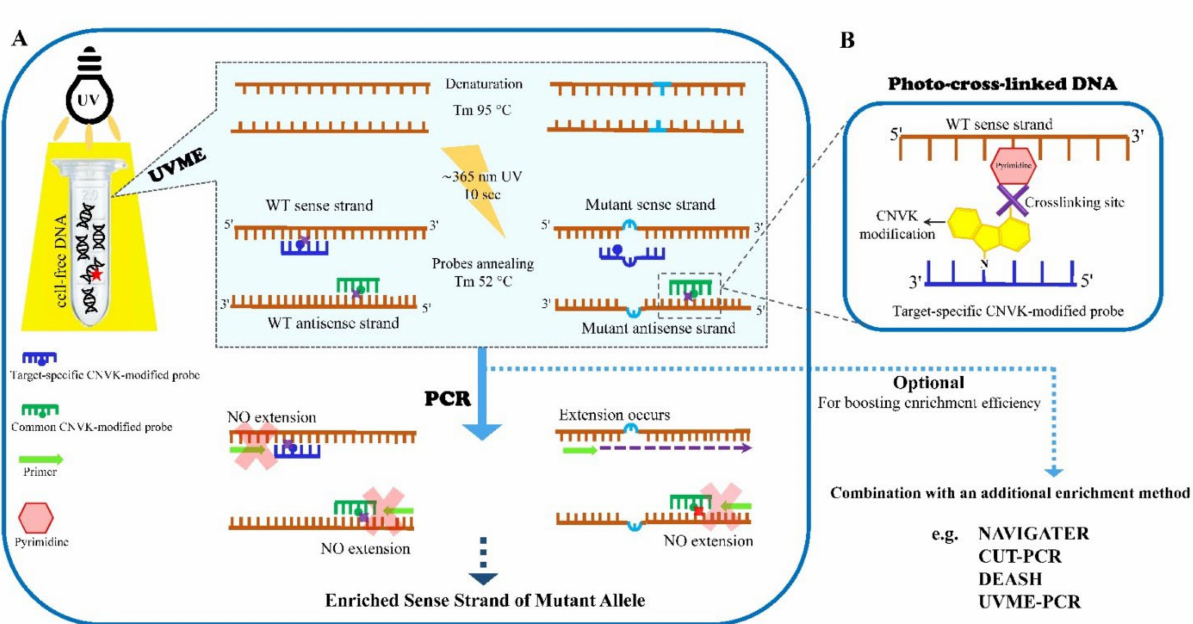
Figure 2. Workflow of pre-PCR-UV-mediated cross-linking minor-allele enrichment (pre-PCR- UVME): ( A ) A UV lamp is employed to induce selective cross-linking of wtDNA. Target-specific CNVK-modified probes bind sense strand of wtDNA, and common CNVK-modified probes attach to antisense strands of both wtDNA and mutated DNA; ( B ) after UV irradiation, fully matched probe–target hybrids undergo photo-crosslinking of CNVK with C or T on the target sequence, thereby inhibiting the proliferation of wtDNA strands and mutant antisense strand during